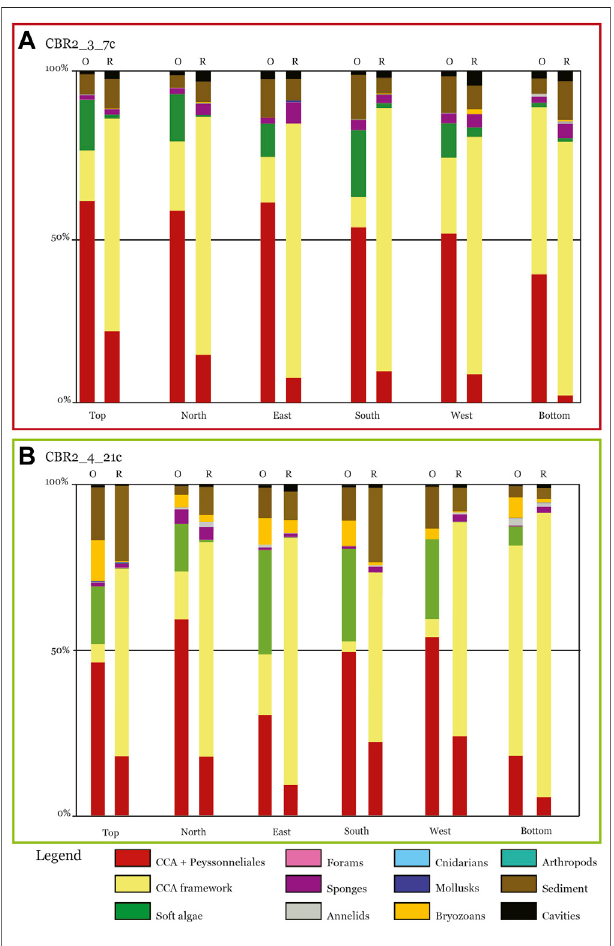
FIGURE 4 | Bar graphs with the cover percentage for each side of the samples (percentage). (A) Sample CBR2_3_7c. (B) Sample CBR2_4_21c. Values are expressed both for the original sample at the time of collection (O) and for the sample after the canopy removal (R).